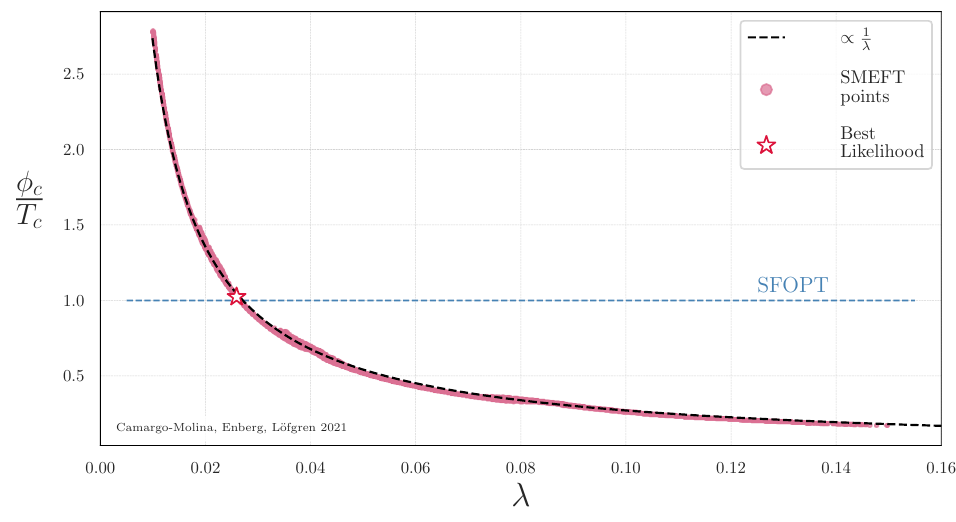
Figure 1 . φ c /T c as a function of λ for the SMEFT parameter points in our study (shown as pink points). A fit proportional to 1 /λ is shown with a black dashed line. φ c /T c > 1 means a strongly first-order transition; the boundary is shown with a blue dashed